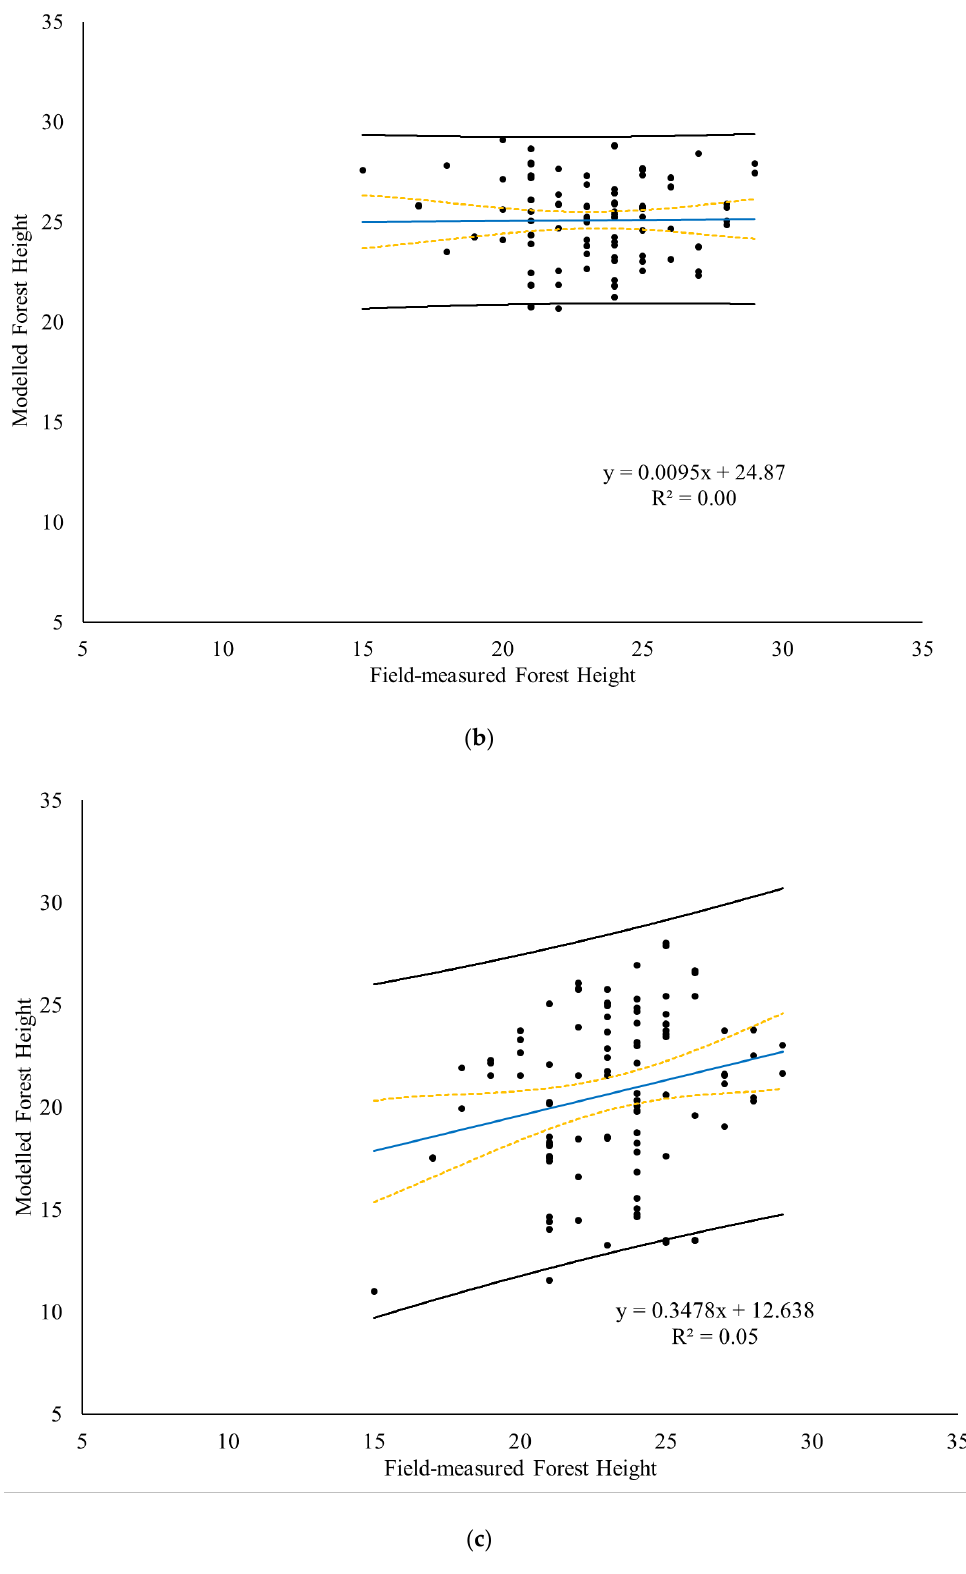
Figure 13. Linear regression with 95% confidence interval for CAI-based inversion modelling of ( a ) L-band SAR data, ( b ) C-band SAR data, and ( c ) X-band SAR data.